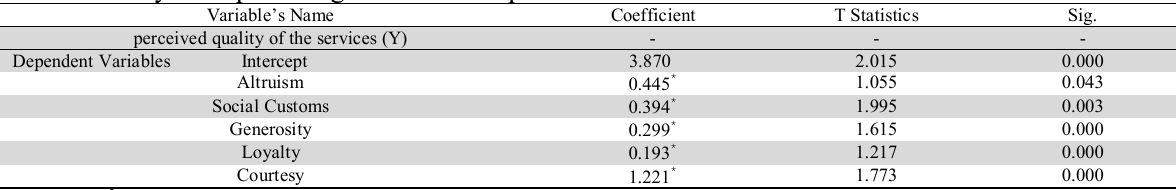
The summary of stepwise regression